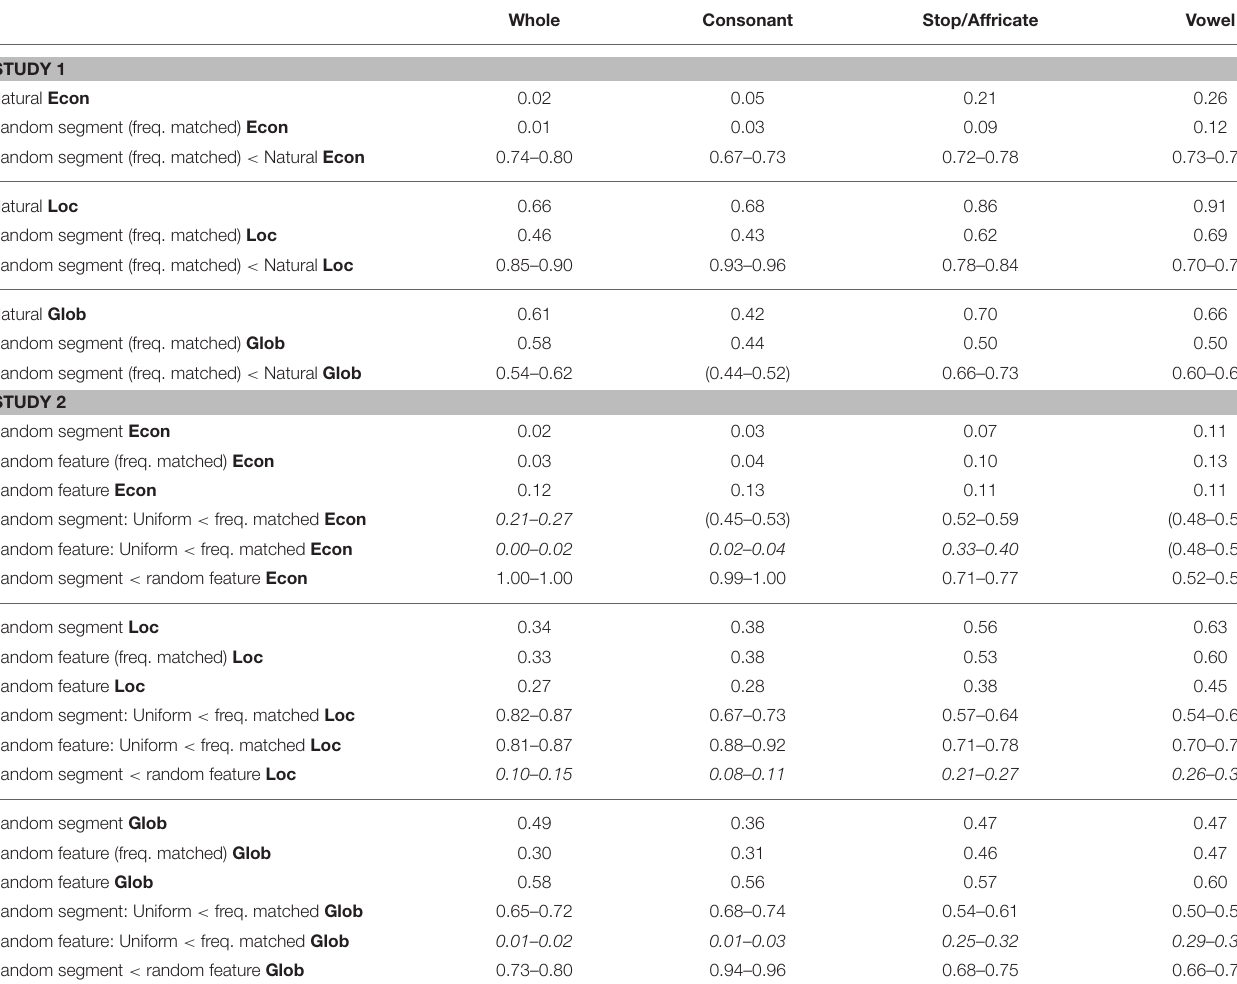
TABLE 1 | Mean values of Econ, Loc, and Glob, with bootstrap AUC 95% intervals for comparisons of distributions. Whole Consonant Stop/Affricate